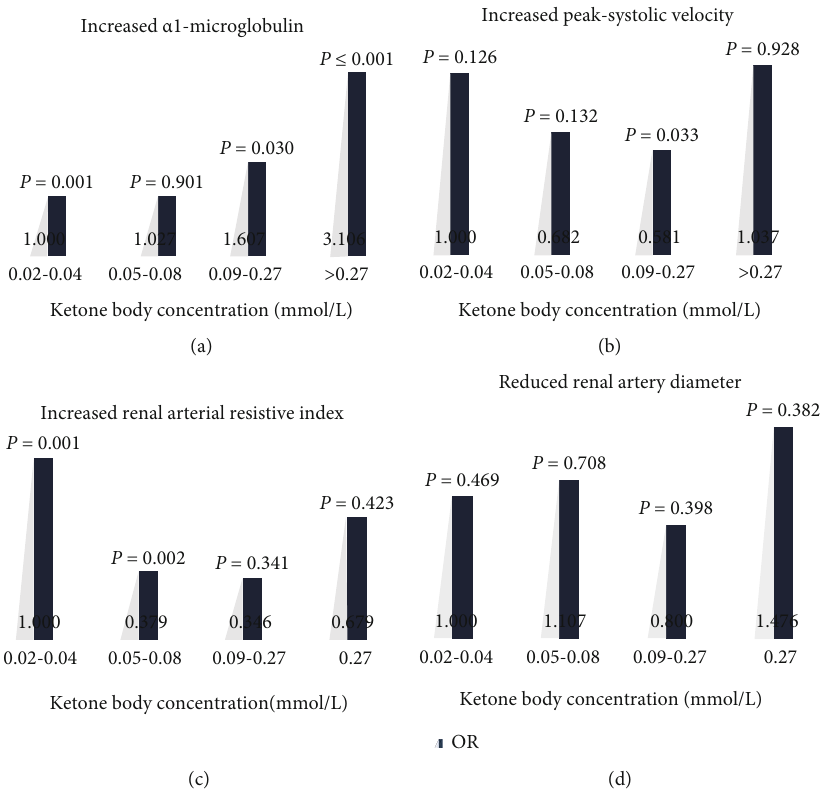
Figure 2: (a) Adjusted ORs of increased α 1-microglobulin in di ff erent KB concentration-based groups. (b) Adjusted ORs of increased peak systolic velocity of renal artery in di ff erent KB concentration-based groups. (c) Adjusted ORs of increased renal arterial resistive index in di ff erent KB concentration-based groups. (d) Adjusted ORs of reduced renal artery diameter in di ff erent KB concentration-based groups. Adjusted for age, duration of diabetes, SBP, DBP, HR, TC, TG, LDL-C, HbA1c, BNU, ALB, BMI, smoking, and